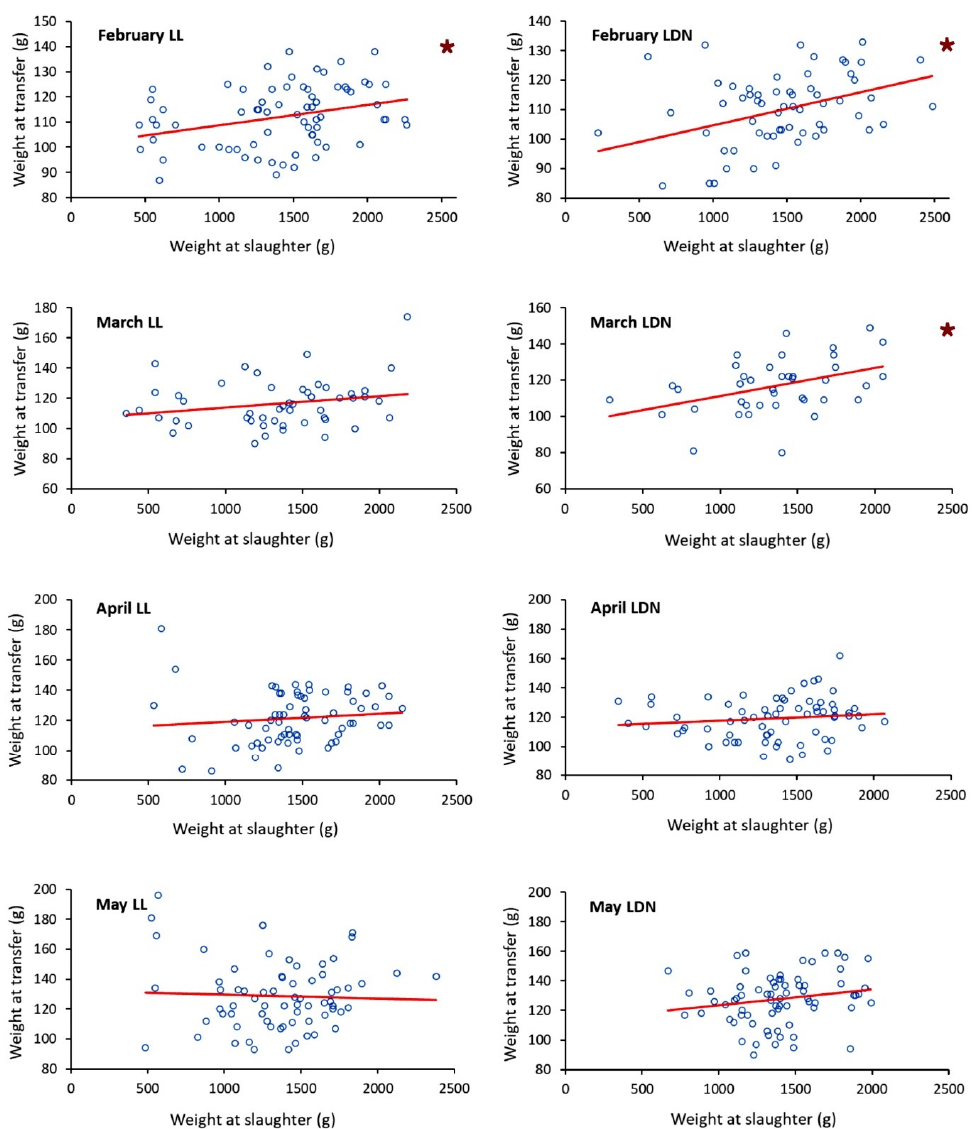
Figure 8. Linear regressions between weight at transfer and weight at slaughter (both in g) for groups of fish transferred to seawater in February, March, April, and May and reared in freshwater either under constant (LL) or natural (LDN) photoperiods. The regression parameters for each case are as follows: February LL ( p < 0.01, R2 = 0.094), February LDN ( p < 0.01, R2 = 0.162), March LL ( p = 0.120, R2 = 0.049), March LDN ( p < 0.01, R2 = 0.172), April LL ( p = 0.384, R2 = 0.012), April LDN ( p = 0.301, R2 = 0.016), May LL ( p = 0.735, R2 = 0.002), and May LDN ( p = 0.117, R2 = 0.035). Asterisks indicate regressions with p -value <